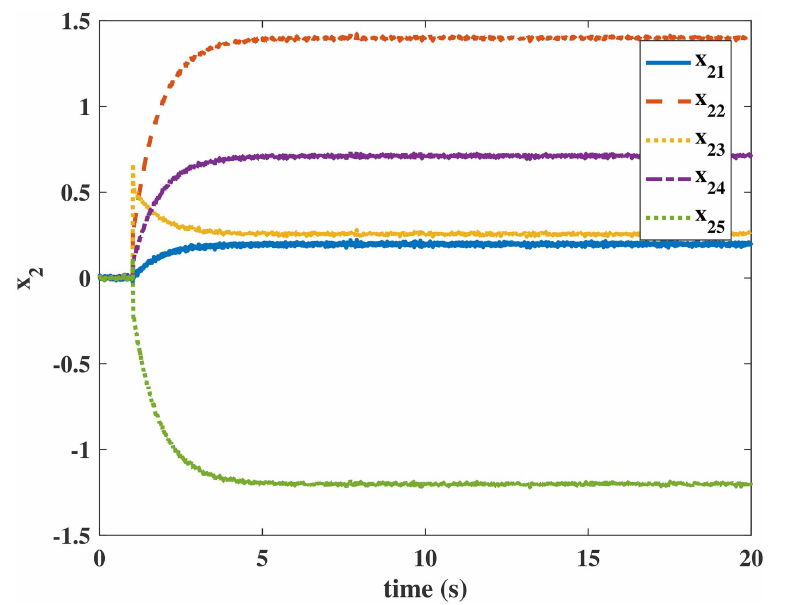
Fig 5. Response of x 2 in the numerical simulation.